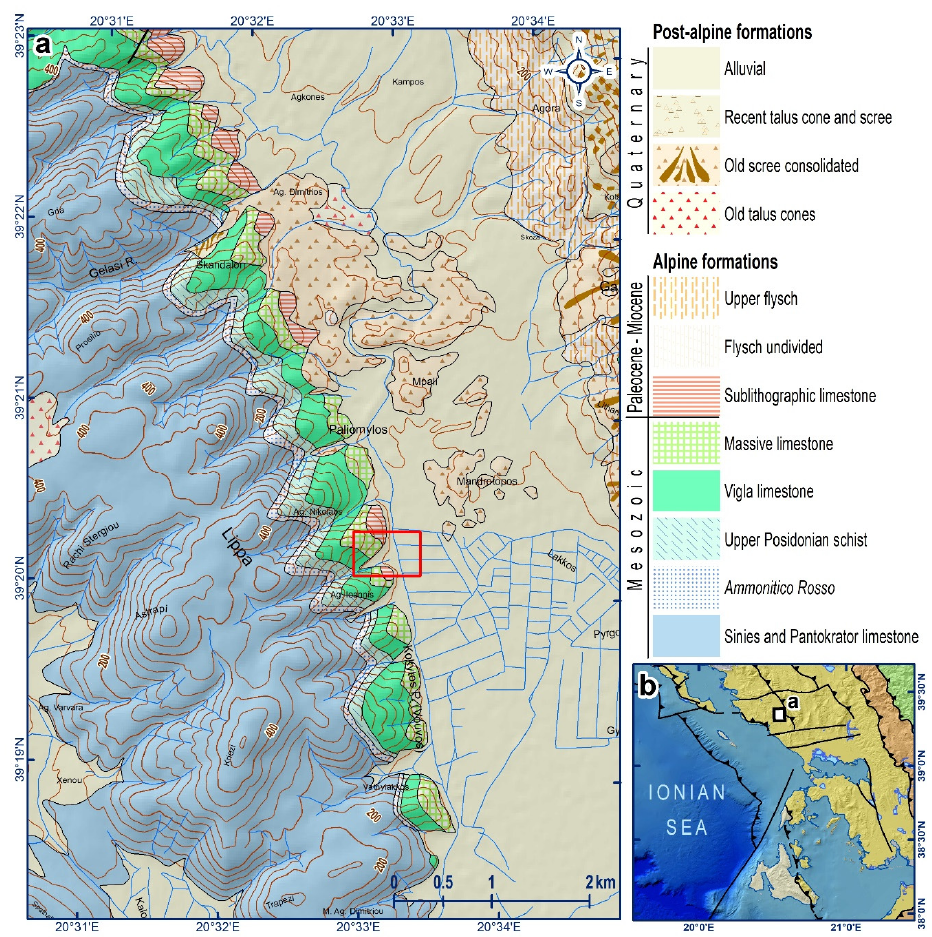
Figure 3. ( a ) General view of the study area based on the existing geological map. The red box indicates the study section. ( b ) Referenced map with the study lithostratigraphic units of the Ionian zone, as depicted in Figure 1. Geological data modified after [55].